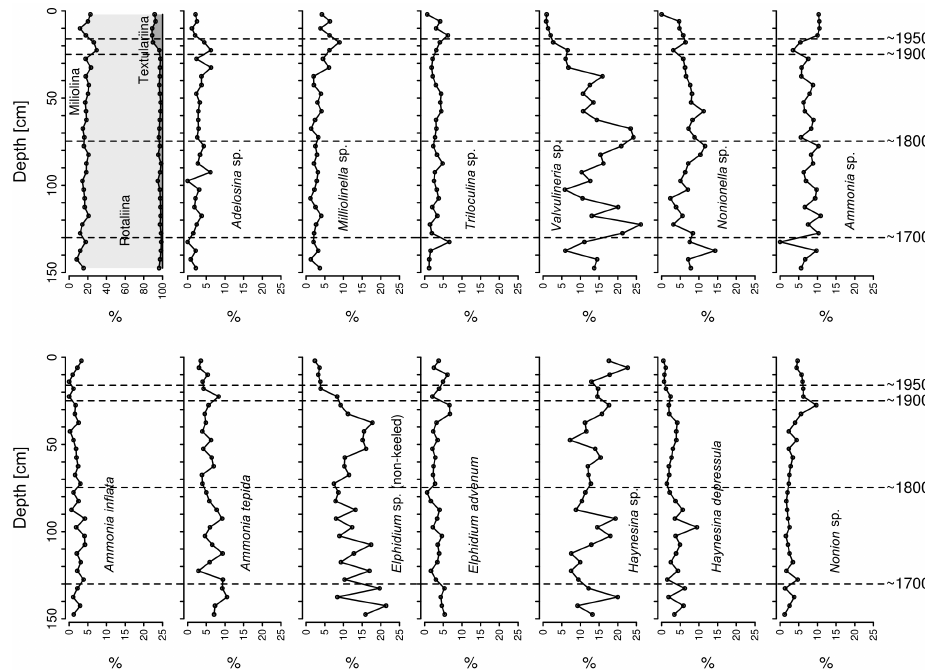
Figure 5. Temporal trends in the relative abundance of foraminiferal suborders (following suprageneric classification of Loeblich and Tappan, 1987) and dominant genera and species (represented by >2% of individuals in the pooled